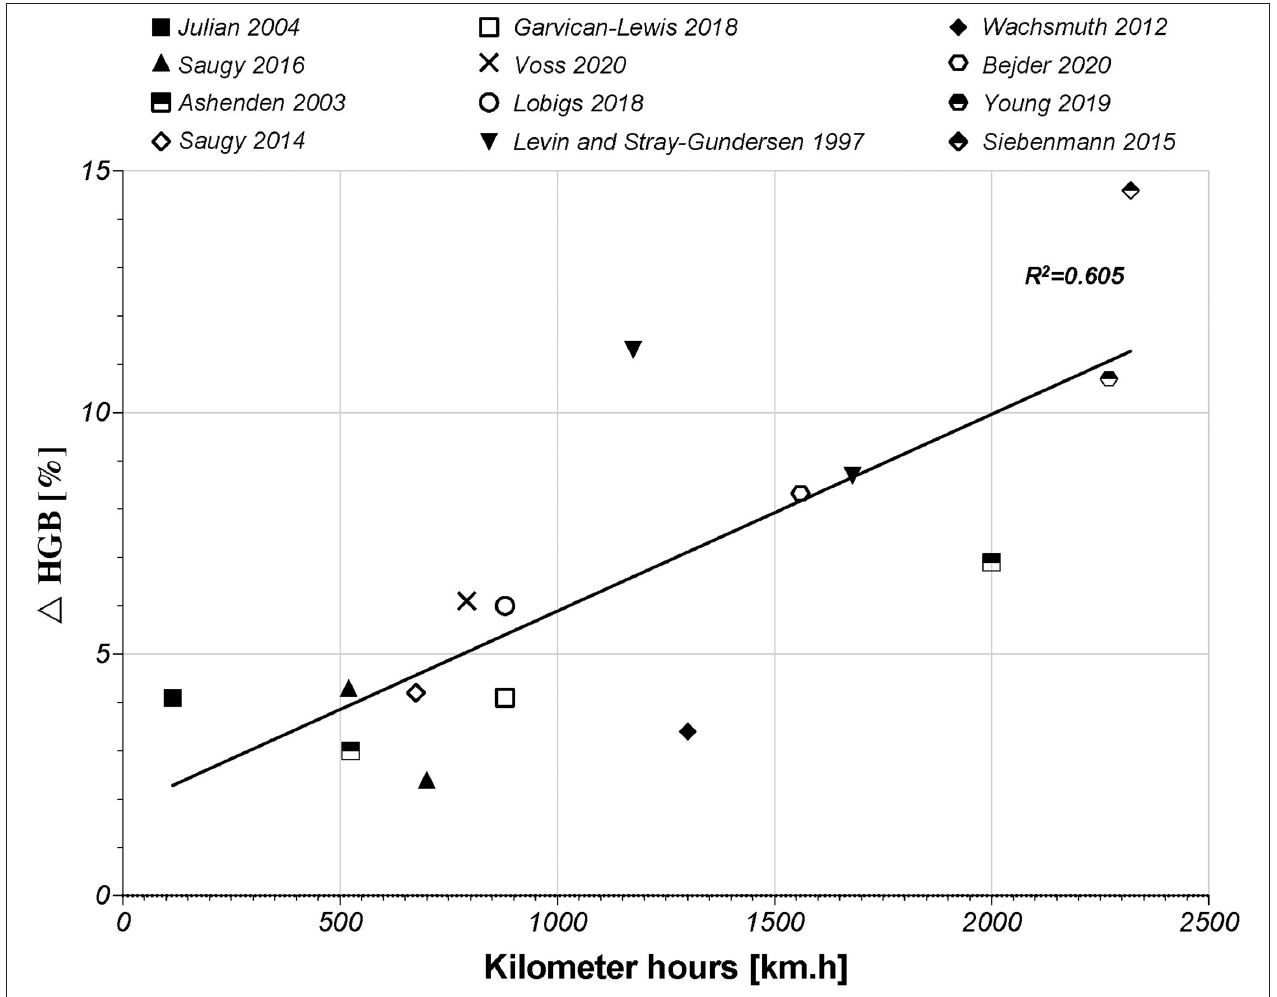
FIGURE 2 | Graphic of the linear correlation between HGB (g/dl) and hypoxic dose (km.h) according to 12 studies of the literature search. HGB, hemoglobin